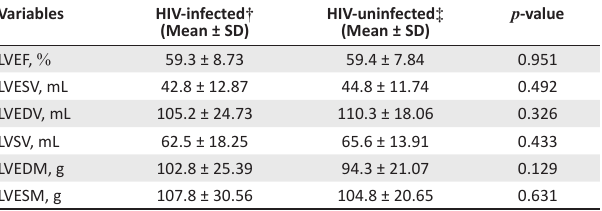
TABLE 2: Cardiovascular magnetic resonance functional analysis.